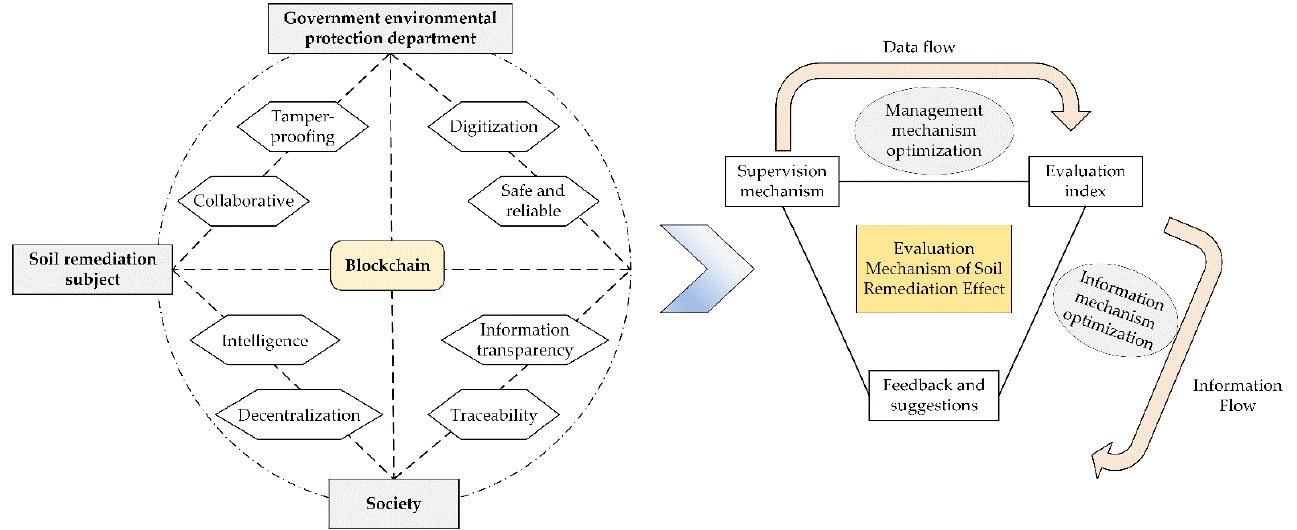
Figure 5. Demand analysis of blockchain technology.